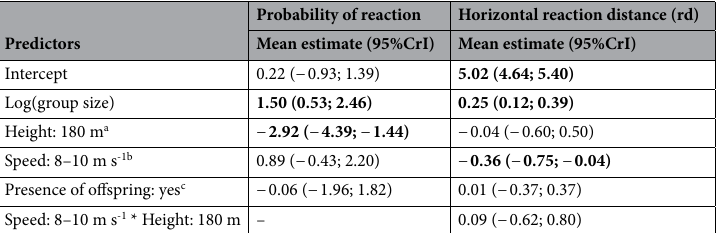
Table 2. Results from a generalized linear model for the probability of reaction and the horizontal reaction distance (rd). We present estimates of the parameters with their 95% credible intervals (CrI) in brackets. A statistically meaningful effect of a fixed factor (presented in bold) can be assumed if zero is not included within the 95% CrI or if the mean difference between compared estimates is higher than 0.95. a Reference level: 60 m. b Reference level: 2–4 m s −1 . c Reference level: without offspring.